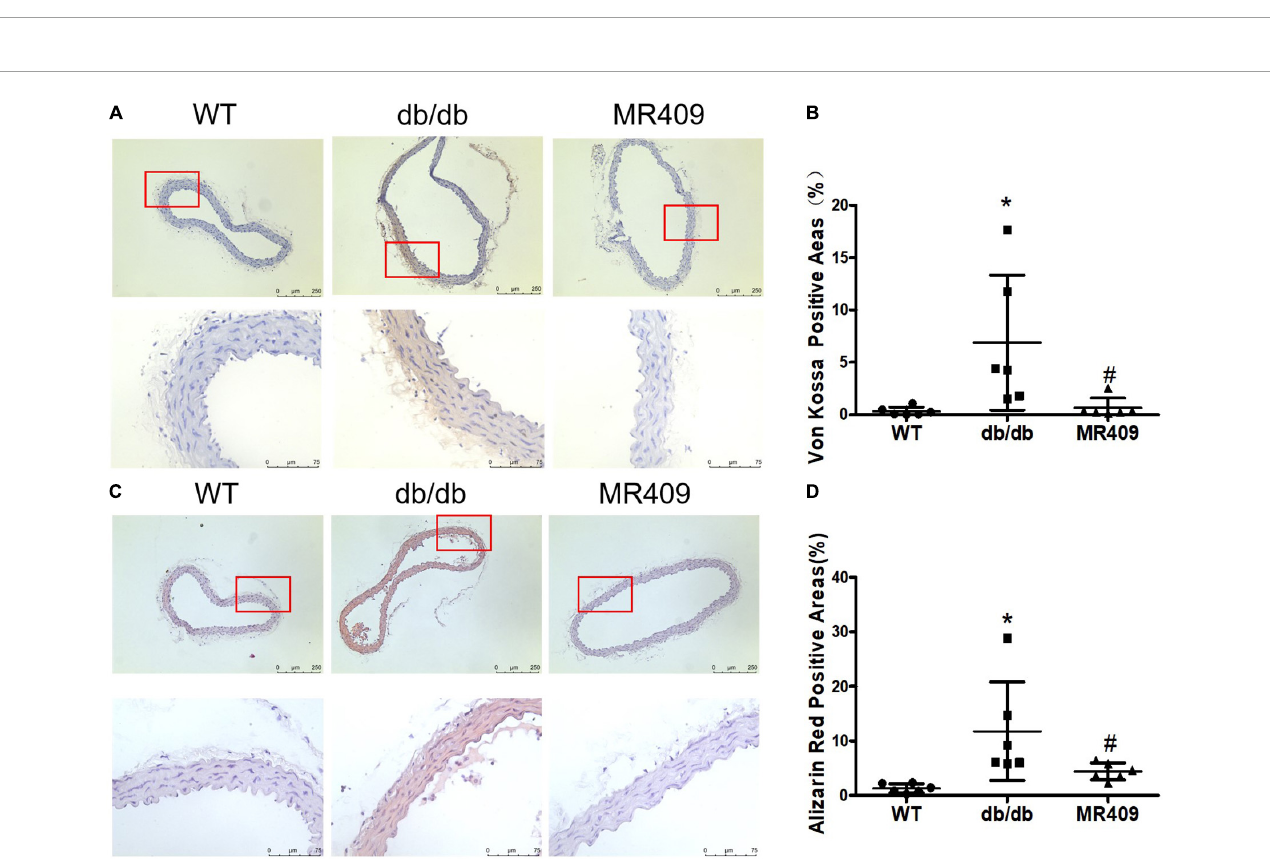
FIGURE5 Treatment with MR409 attenuates calcium deposition in aortic root section of diabetic db/db mice. The representative images of calcium staining in the aorta by Von Kossa with a low magnification in up pane and a high magnification in low pane (brown, A ) and alizarin red staining with a low magnification in up pane and a high magnification in low pane (dark red, C ), the quantitation of positive calcium staining areas with Von Kossa (B) and alizarin red (D) . N = 6, * p < 0.05 diabetic mice vs. WT mice, # p < 0.05 MR409 treated mice vs. diabetic mice.